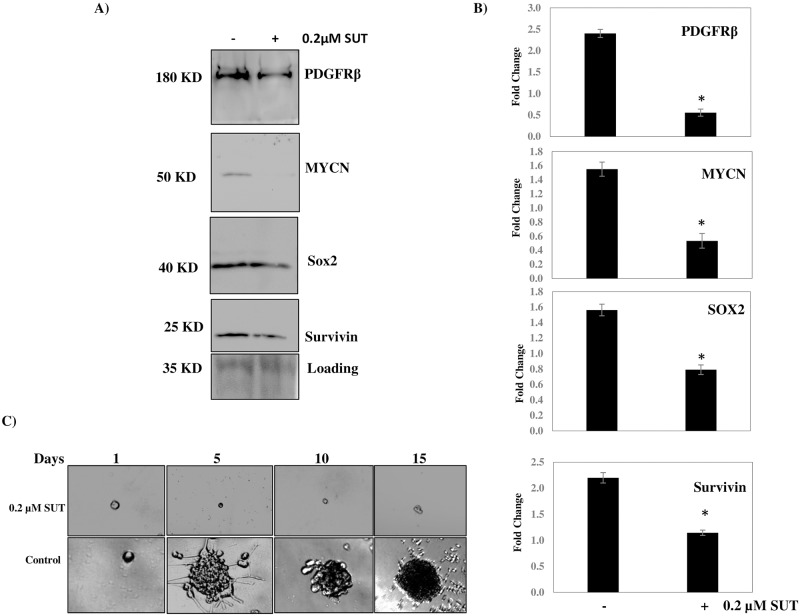
Long-term sutent treatment in AI tumorspheres inhibits tumorigenic protein expression and tumorsphere self-renewal.AI tumorspheres were treated with 0.2 μM sutent for 48 h and then lysed for Western blot analysis. A) Western blot images of representative experiments illustrating the reduced expression of PDGFRβ, MYCN, SOX2 and Survivin after 48 h sutent treatment. B) Densitometric analysis of multiple Western blot experiments showing statistically significant reduction in the protein expression of the above mentioned proteins. C) Micro-images of tumorsphere self-renewal capacity over 15-days, inhibited with 0.2 μM sutent treatment. * indicates a P value < 0.05. Results represent the mean ± SEM of multiple experiments.